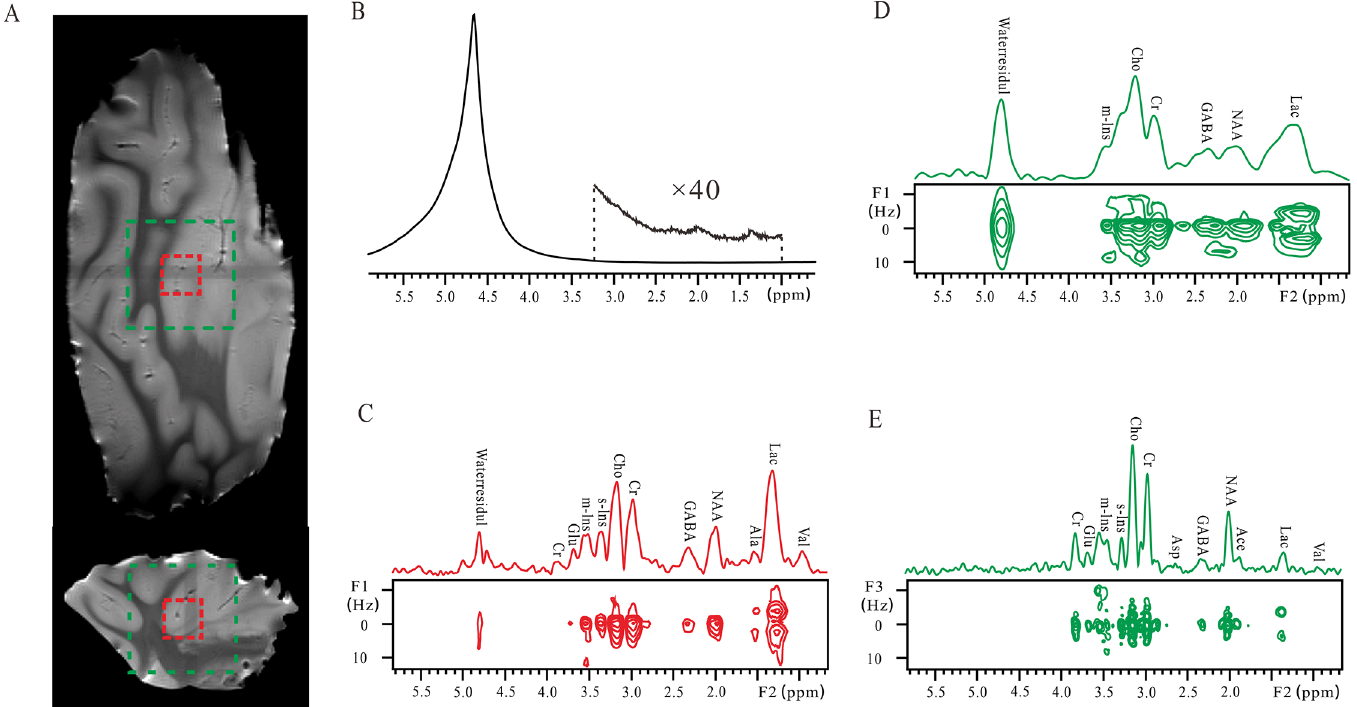
Fig 3. Results of an intact pig brain tissue. (A) Spin echo images of the sample. A large voxel of 18 × 18 × 18 mm 3 is marked by a green dashed rectangle, and a small voxel of 6 × 6 × 6 mm 3 is marked by a red dashed rectangle. (B) Conventional 1D non-localized spectrum and the expanded region for metabolites. (C) Conventional 2D J PRESS spectrum after a clockwise rotation of 45° and its projection along the F2 axis acquired from the small voxel after the field shimming procedure. (D) Conventional 2D J PRESS spectrum after a clockwise rotation of 45° and its projection along the F2 axis acquired from the large voxel without the field shimming procedure. (E) 2D localized iDQC J RES spectrum and its 1D J -decoupled projection along the F3 axis acquired from the large voxel without the field shimming procedure.